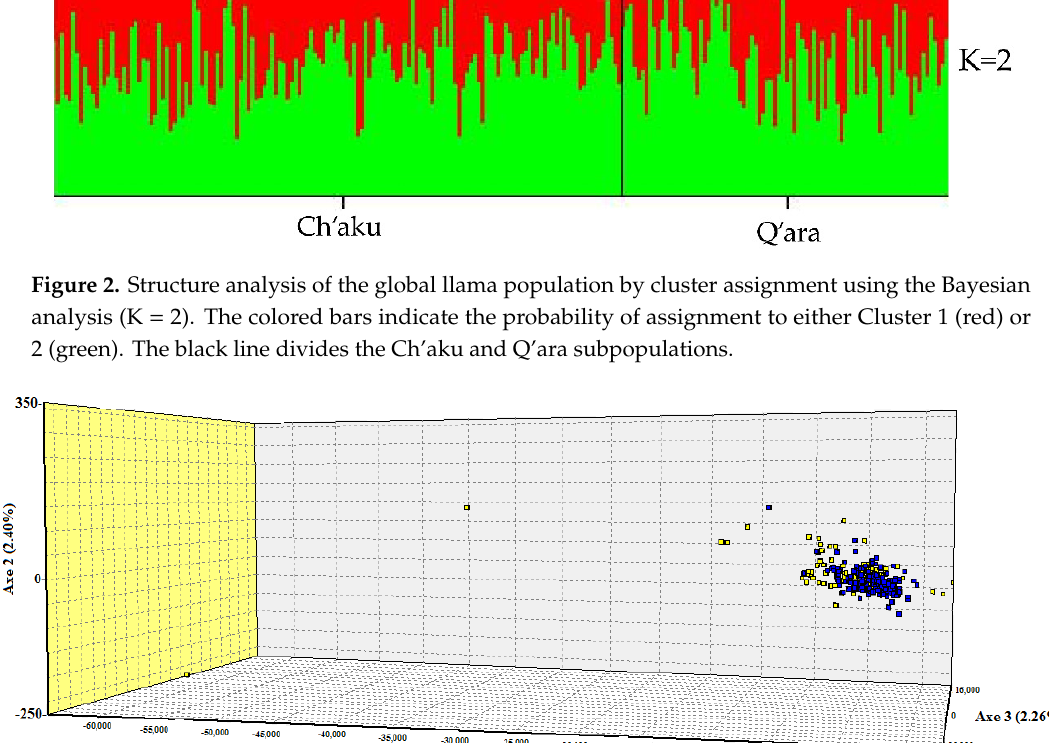
Figure 3. Factorial correspondence analysis between the Ch’aku and Q’ara subpopulations. Yellow, Ch’aku; Blue, Q’ara.